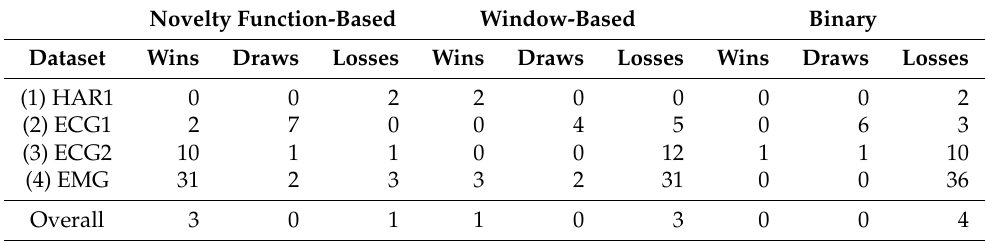
Table 2. Points table recording segmentation match between the novelty-based (novelty), window- based (WL), and binary (BS) segmentation approaches on different datasets in the format of “Win/Draw/Lose” based on F1-scores. The last row reports the points for all datasets. Novelty